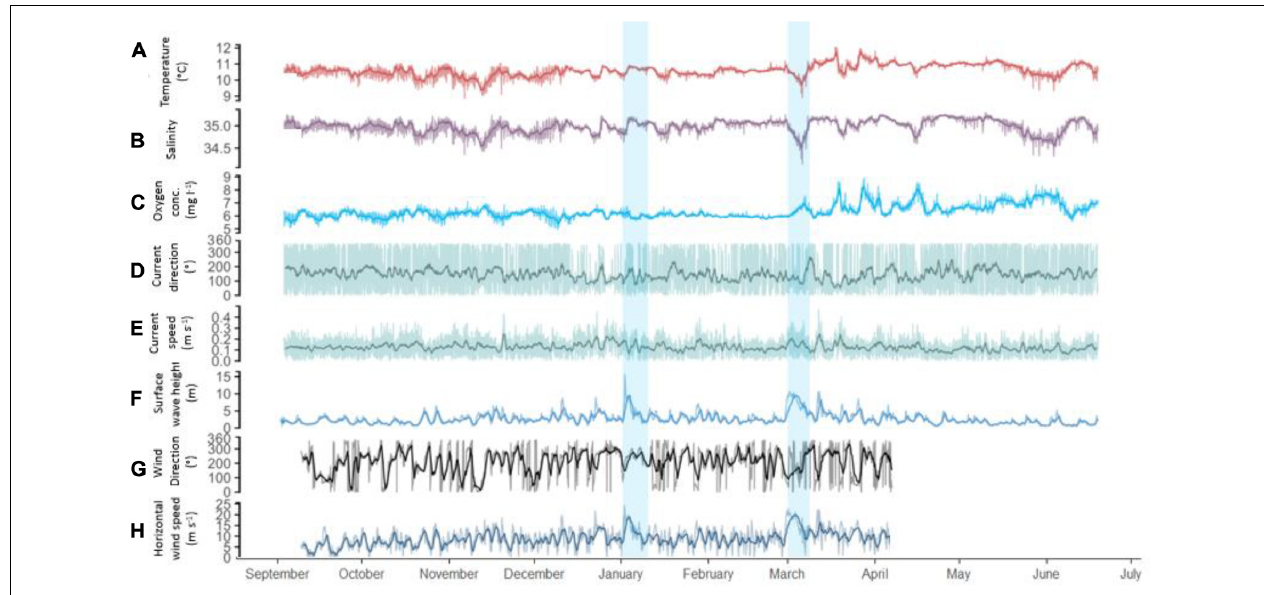
FIGURE 3 | Near-bed hydrodynamic data, recorded by the lander from September 2017 to June 2018, with the daily moving average shown by thick lines. (A) Temperature, (B) Salinity, (C) Dissolved Oxygen concentration, (D) Current direction (5 mab), (E) Current speed (5 mab). Weather data from buoy: (F) Wave height; (G) wind direction and (H) wind speed (no continuous record) (DFO). Storm events are highlighted in light